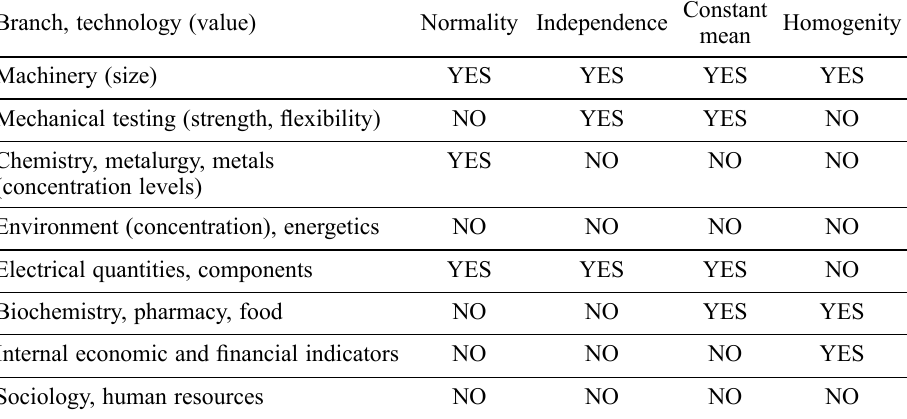
Table 1. Typical violations of assumptions for the application of regulation by Shewhart´s charts in different